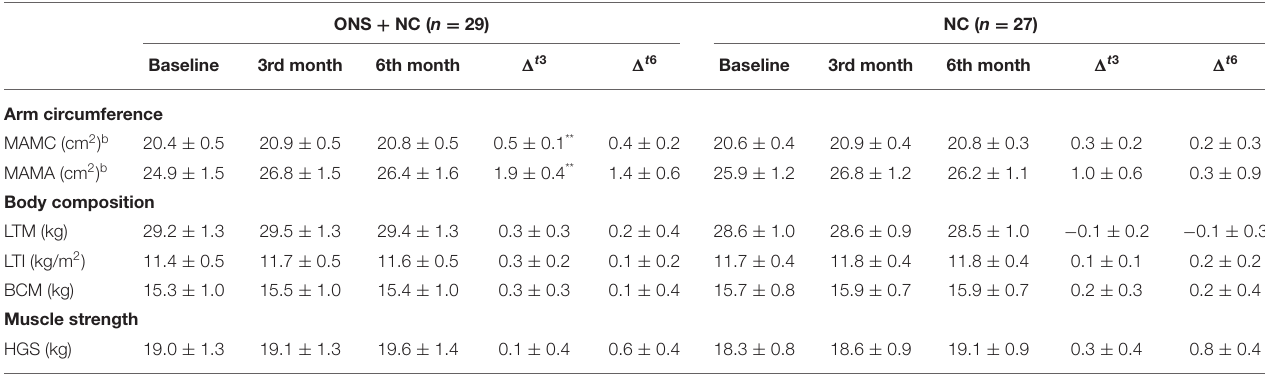
TABLE 2 | Changes in other muscle indices according to treatment